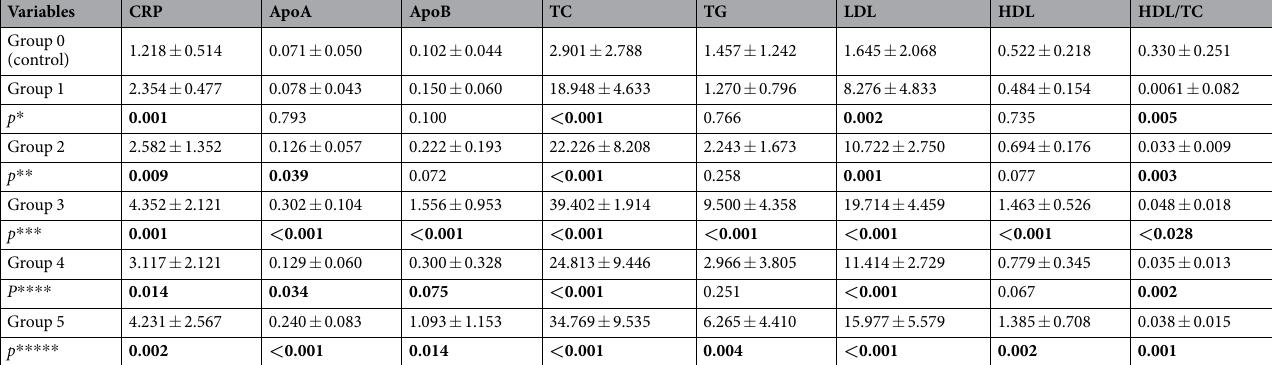
Table 1. The plasma lipid profile of every group. p * : Group 1 VS Group 0; p ** : Group 2 VS Group 0; p *** :